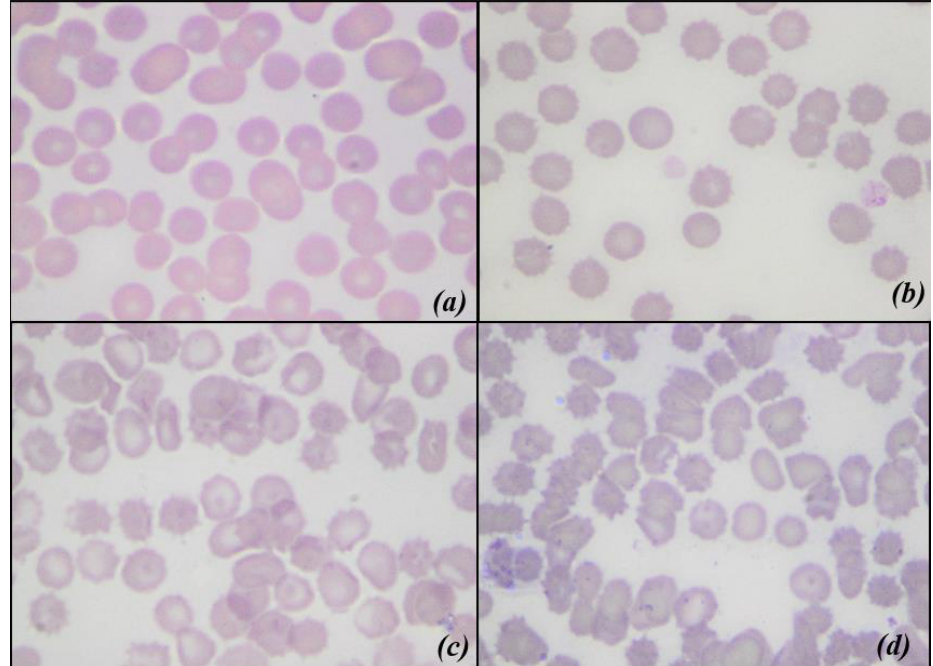
Figure 10. Optical microscopic scans of leukoreduced whole blood showing morphological changes during storage. ( a ) corresponds to T0 red blood cells with normal biconcave disc shape; ( b ) corresponds to T14; ( c ) correspond to T28 and ( d ) corresponds to T42 progressive changes in shape. The percentages of hemolysis at T0 (basal hemolysis) showed an interindividual variability between subjects, although this was not